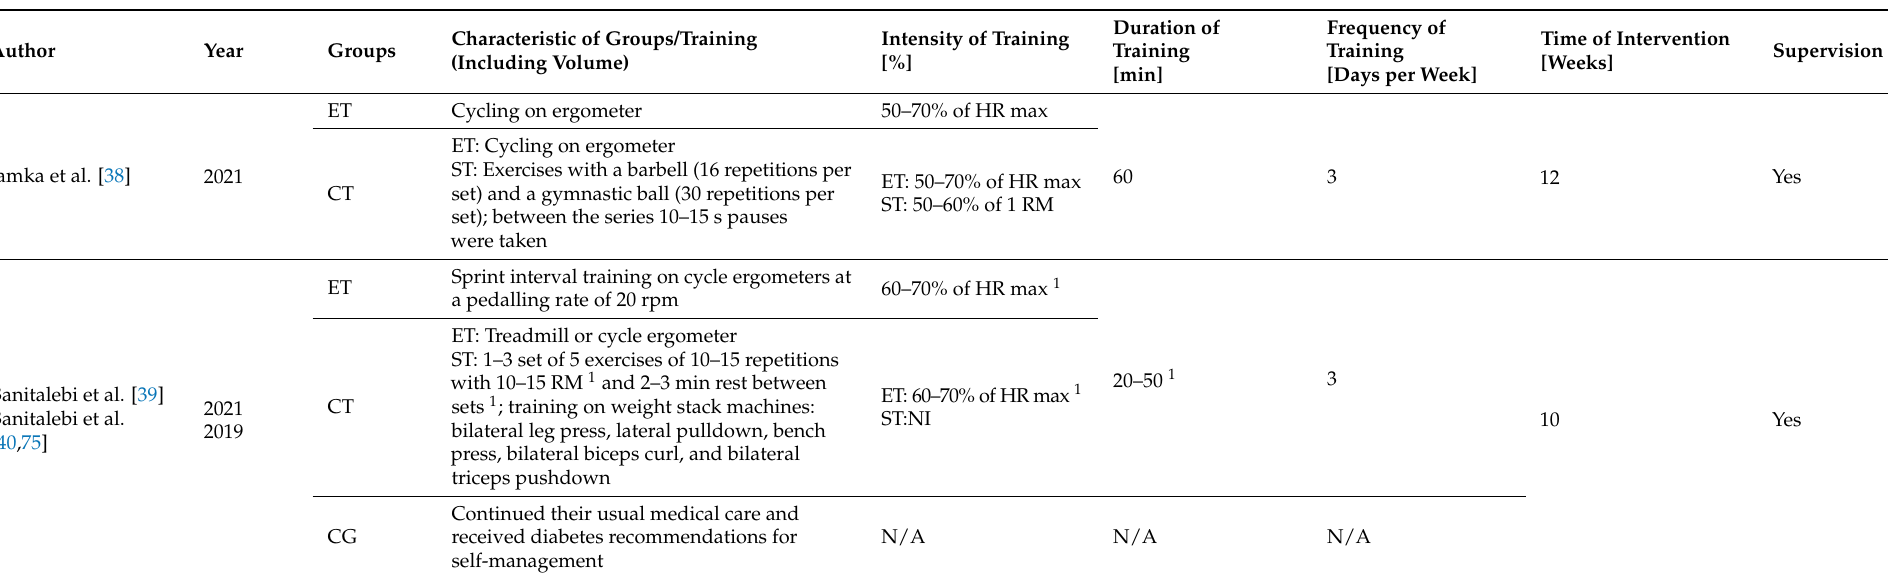
Table 2. Characteristics of training